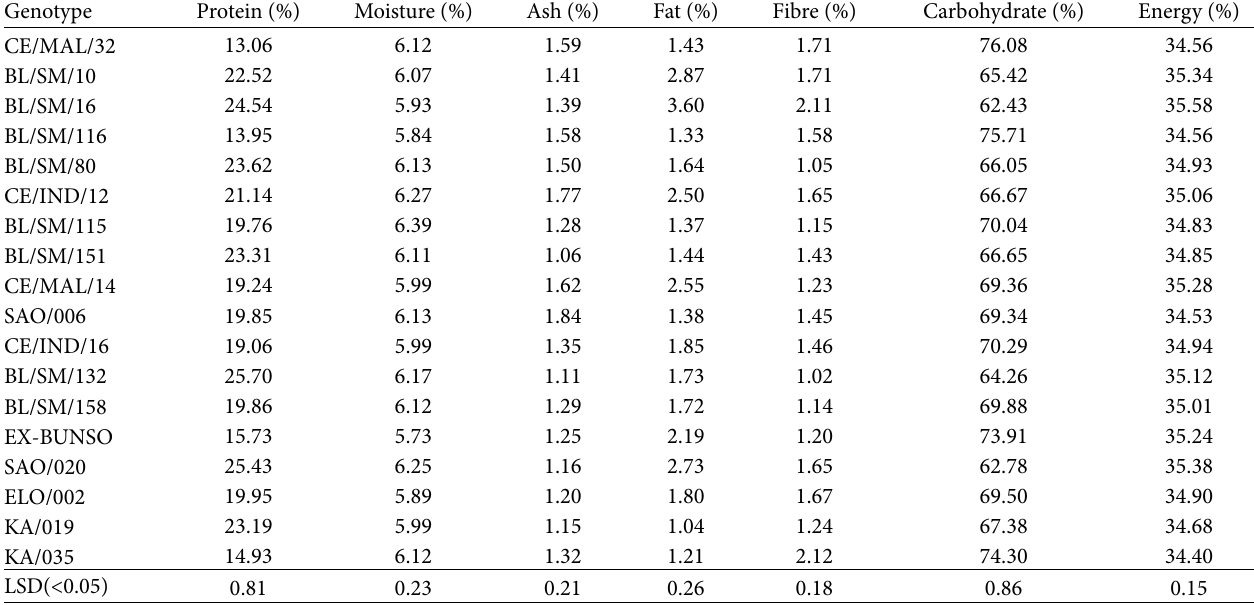
Table 2: Chemical composition of the 18 taro genotypes.